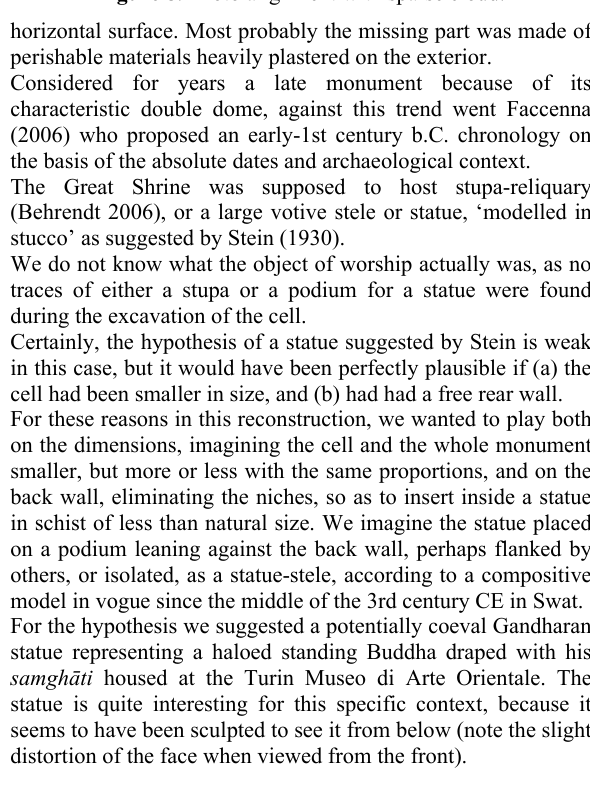
Figure 8 . Photo alignment with sparse